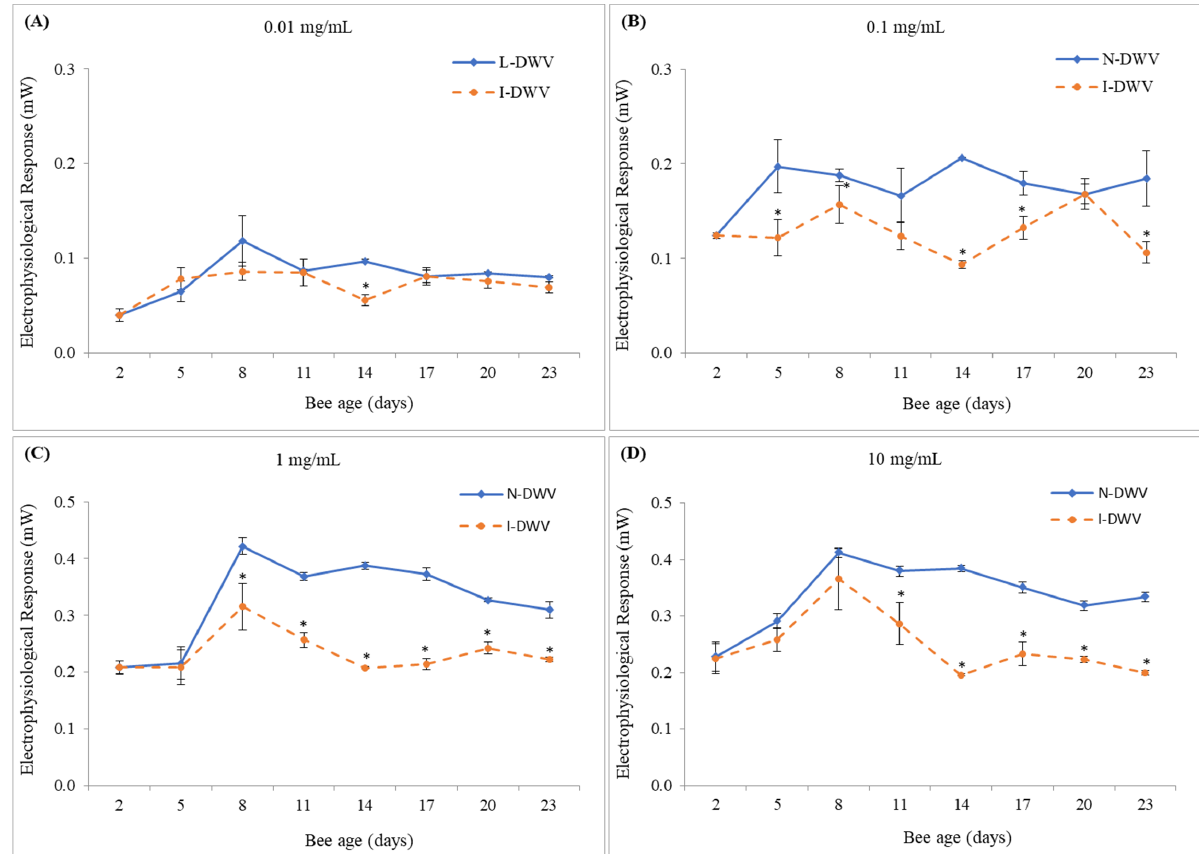
Figure 2. Electrophysiological response of inoculated and non-inoculated worker bees exposed to essential oil of Mentha piperita. Uppercase letter in each subfigure represent the essential oil at concentration of ( A ) 0.01, ( B ) 0.1, ( C ) 1.0 and ( D ) 10.0 mg/mL. Asterisks indicate significant differences for the same sampling time in bees that were inoculated (I-DWV) and non-inoculated (N-DWV) with DWV-A, according to the Bonferroni test ( p < 0.05). The bar in each age indicates standard error.